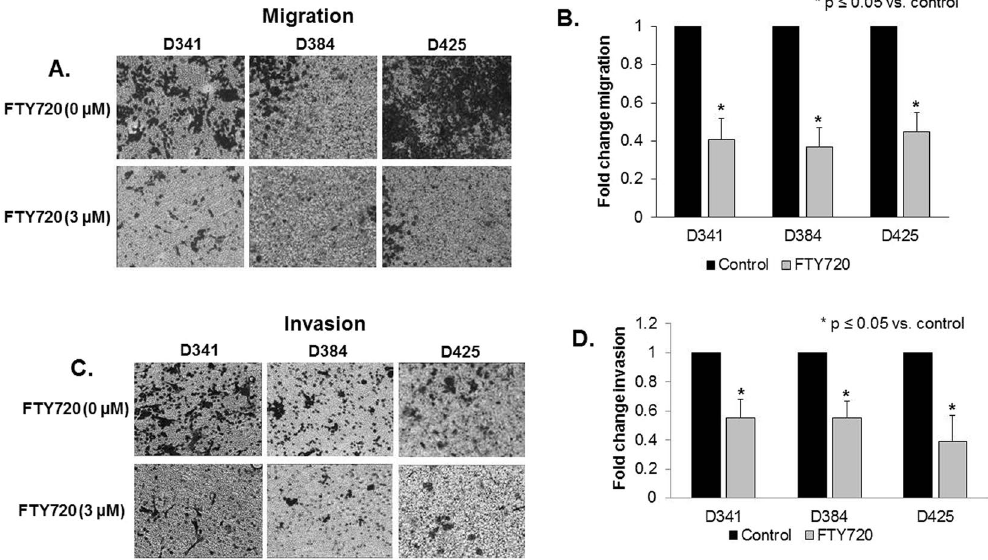
Figure 5. Migration and invasion of medulloblastoma PDX cells was decreased after treatment with FTY720. ( A ) Migration was determined using Transwell ® inserts with 8 μ M pores, coated on the bottom with laminin. Cells were treated with FTY720 (0, 3 µ M) for 24 hours and allowed to migrate for 24 hours. Representative photographs of the inserts show decreased cell migration in all 3 PDXs with FTY720 treatment. ( B ) The number of cells migrating was quantitated and reported in graphic form, again showing over 50% decrease in migration in all 3 PDXs after treatment with FTY720. ( C ) Invasion was completed using Transwell ® inserts with 8 μ M pores, coated on the bottom with laminin and the inside of the inserts coated with Matrigel ™ . Cells were treated with FTY720 (0, 3 µ M) for 24 hours and allowed to invade for 24 hours. Representative photographs of the inserts show decreased cell invasion in all 3 PDXs with FTY720 treatment. ( D ) The number of cells invading was quantitated and reported in graphic form, demonstrating significantly decreased invasion in all 3